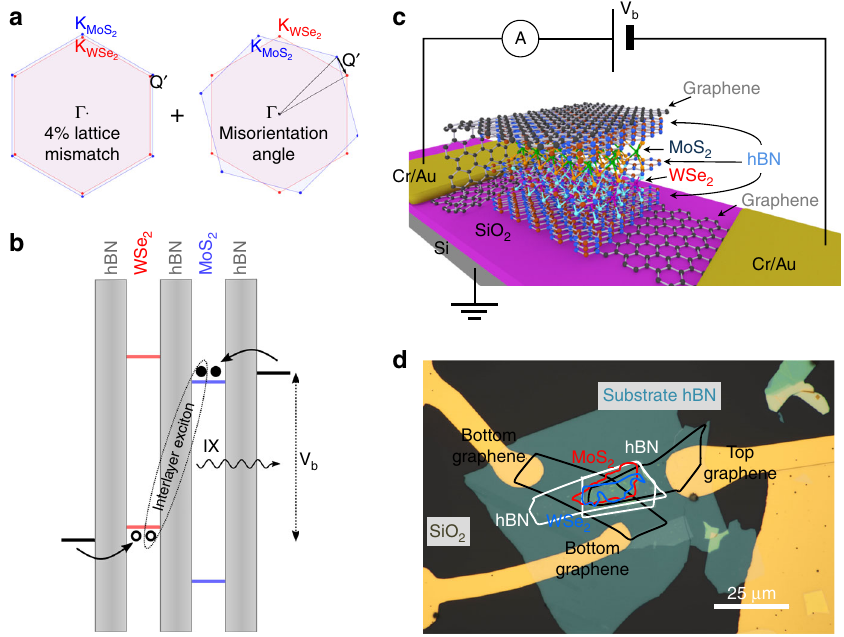
Fig. 1 Sample structure and selective charge carrier injection. a Brillouin zones of WSe 2 (red) and MoS 2 (blue) illustrating the momentum Q ’ arising due to lattice mismatch and misorientation angle. b Schematic illustration of the type-II band alignment for the MoS 2 /WSe 2 heterostructures with a middle monolayer hBN spacer. The conduction and valence band of WSe 2 (MoS 2 ) are represented by red (blue) lines. The hBN layers are represented by gray- shaded rectangles. The black lines depict the quasi Fermi levels in the bottom and top graphene electrodes for an applied voltage above the threshold for hole tunneling into WSe 2 and electron tunneling into MoS 2 . The dashed ellipse indicates the formation of an interlayer exciton consisting of an electron in the conduction band of MoS 2 and a hole in the valence band of WSe 2 . c Schematic drawing of the heterostructure shown in ( b ). d Optical microscope image of the active area of device